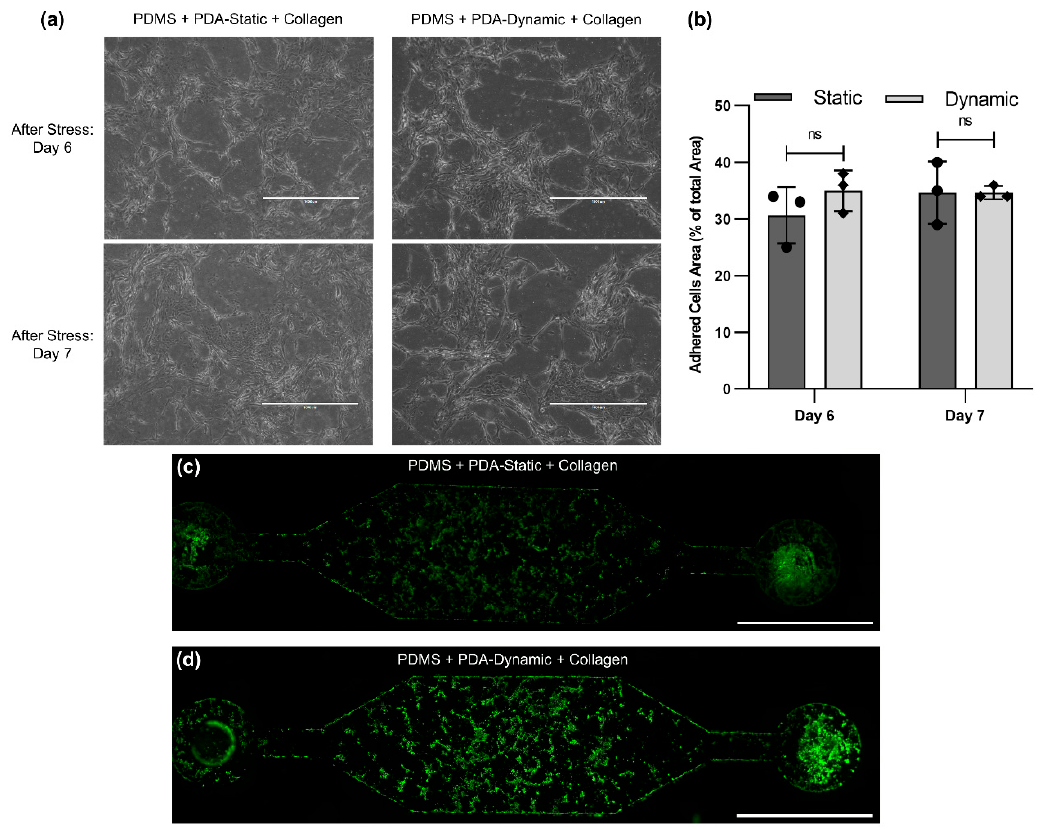
Figure 4. HBECs after flow stress test: ( a ) Bright-field image of HBECs adhered on PDA-static-collagen-coated and PDA-dynamic-collagen-coated surfaces at Day 6 (one day after flow stress test) and Day 7 (two days after flow stress test), ( b ) the adhered cell area as a percentage of the total area at Day 6 and Day 7 for static and dynamic conditions, and a fluorescence image of HBECs adhered in a PDMS-treated microfluidic device using ( c ) PDA-static-collagen coating and ( d ) PDA-dynamic-collagen coating.